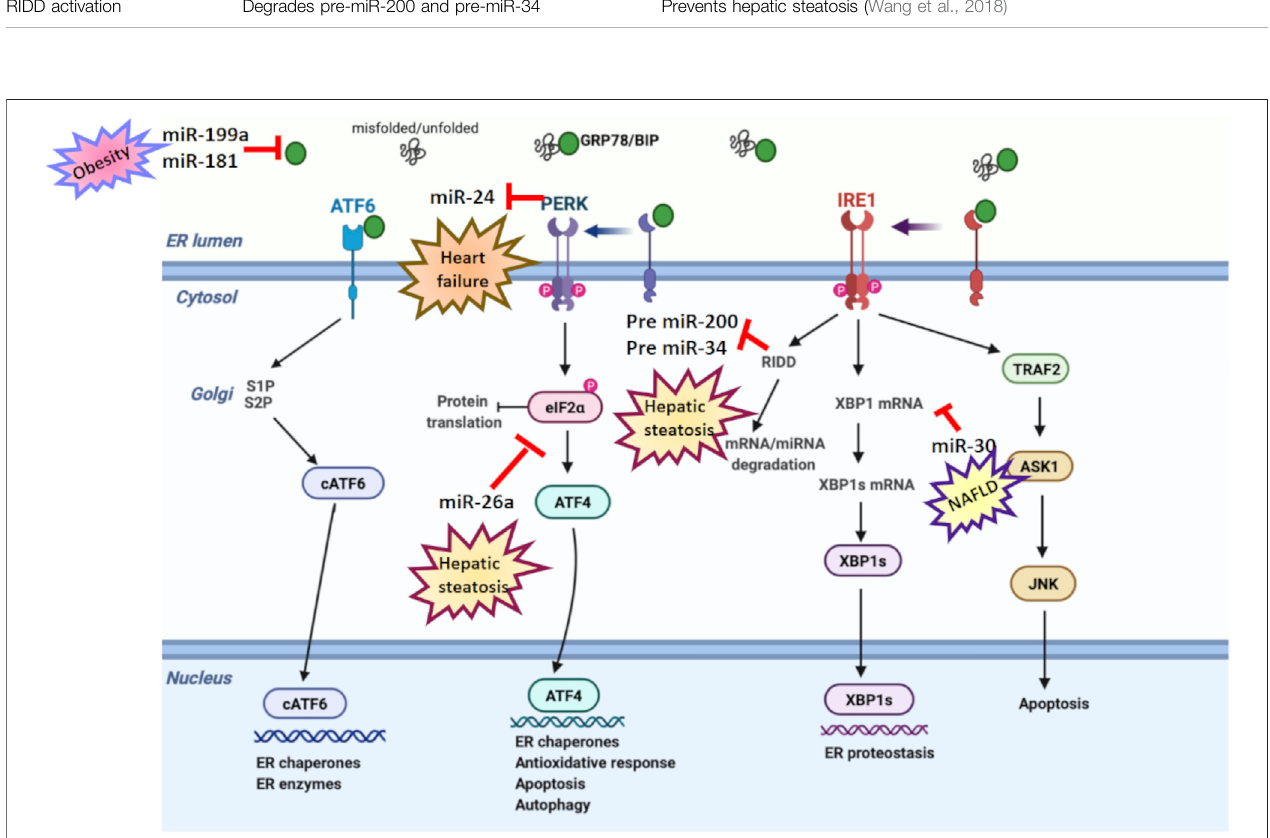
FIGURE 3 | ER stress and microRNA relation in age-related diseases. Various studies have reported a dual relation between miRNA and ER stress in age-related disorders. miR-199a and miR-181 suppress GRP78 expression in obesity. miR-30 downregulates XBP-1 expression in NAFLD. miR-26a reduces eIF2 α in hepatic steatosis. However, PERK suppresses miR-24 in heart failure, while RIDD activation degrades pre-miR-200 and pre-miR-34 in hepatic steatosis.